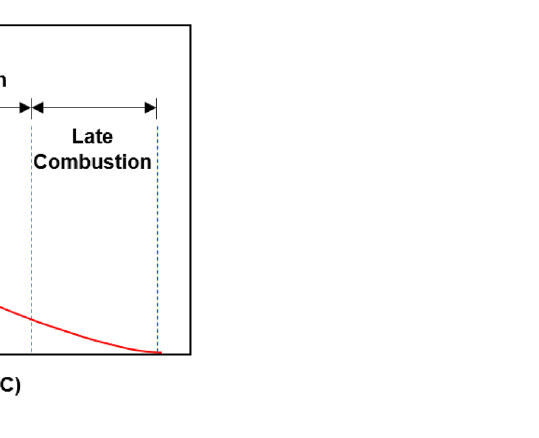
Figure 4. Combustion phase of diesel fuel 33